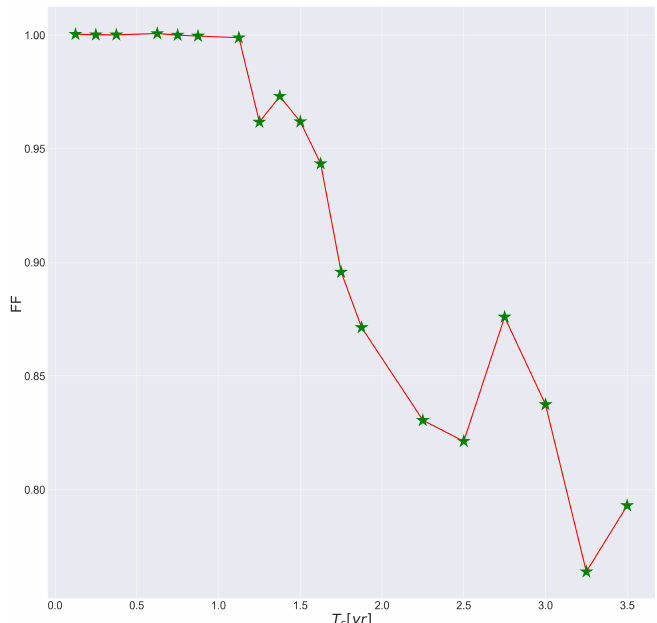
Figure 1. Fitting factor as a function of the observing time of GWs. The two waveforms which are compared here are h 1 , the waveform of a low-mass BBH residing in a gaseous environment, and h 2 , a high-mass BBH in vacuum. The input parameters are M = 8.7 M (cid:12) , q = 0.7, a = 0.002 AU, and T gas (cid:39) 10 3 years. The best-fit chirp mass, corresponding to the highest FF, is M o (cid:39) 37 M (cid:12)